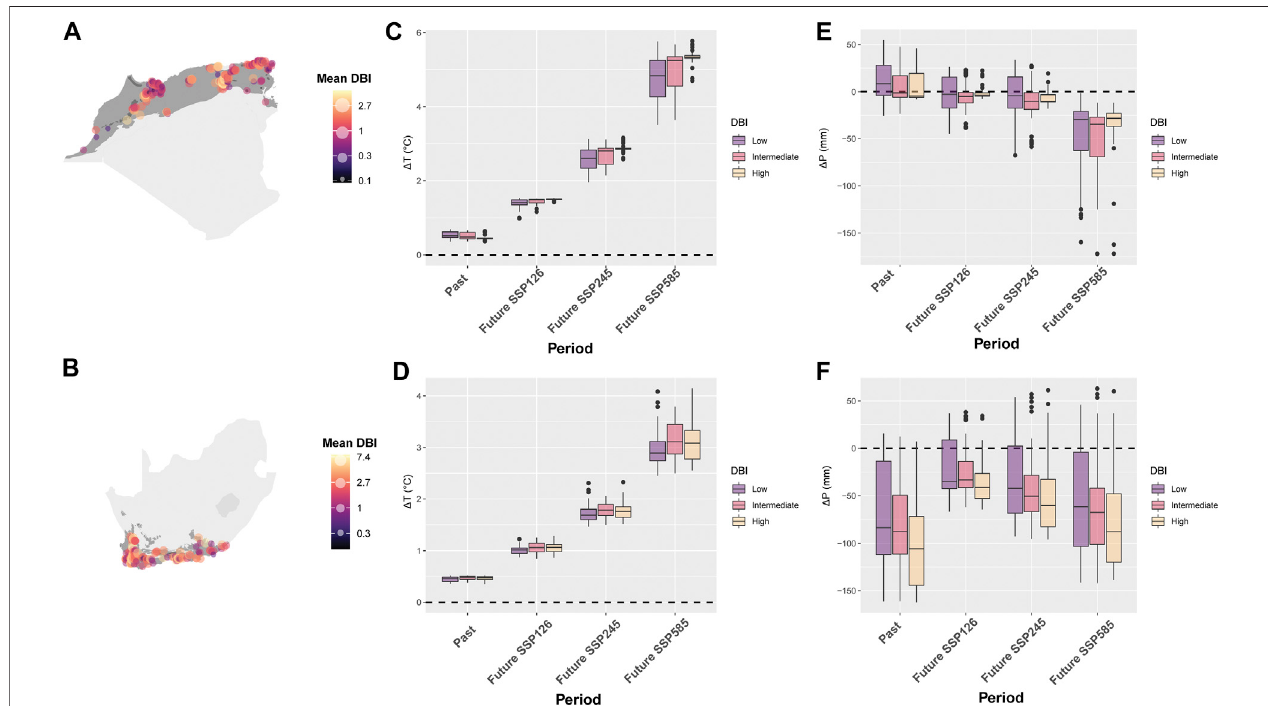
FIGURE 5 | Change in average temperature ( Δ T) and annual precipitation ( Δ P) for odonate assemblages with low, intermediate, and high mean Dragon fl y Biotic Index (DBI) in the Mediterranean climate of the North African Region (NAR) and South African Region (SAR). (A) mean DBI in all sites of NAR. (B) mean DBI in all sites of SAR. (C) Δ TinNAR. (D) Δ TinSAR. (E) Δ PinNAR. (F) Δ PinSAR.Theperiod1980 – 1999isusedasareferenceperiodtocalculatepast(differencebetween2000 – 2018 and 1980 – 1999) and future (difference between 2081 – 2100 and 1980 – 1999) change in climatic conditions. Three scenarios were used for the future projection of climate: SSP 126, 145, and